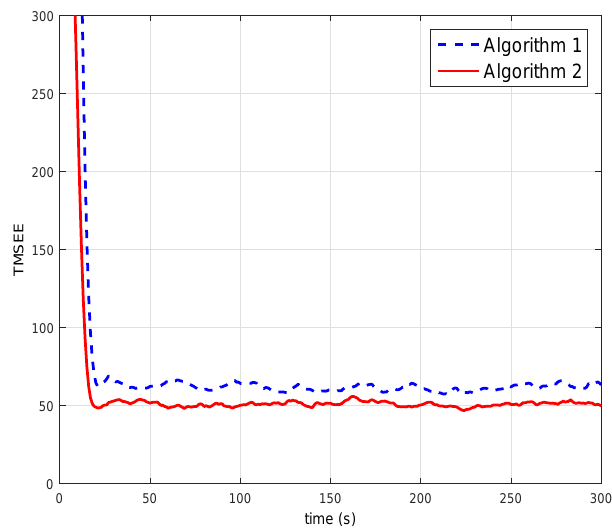
Figure 7. Comparison between RSKCF and ETKCF with constraints.